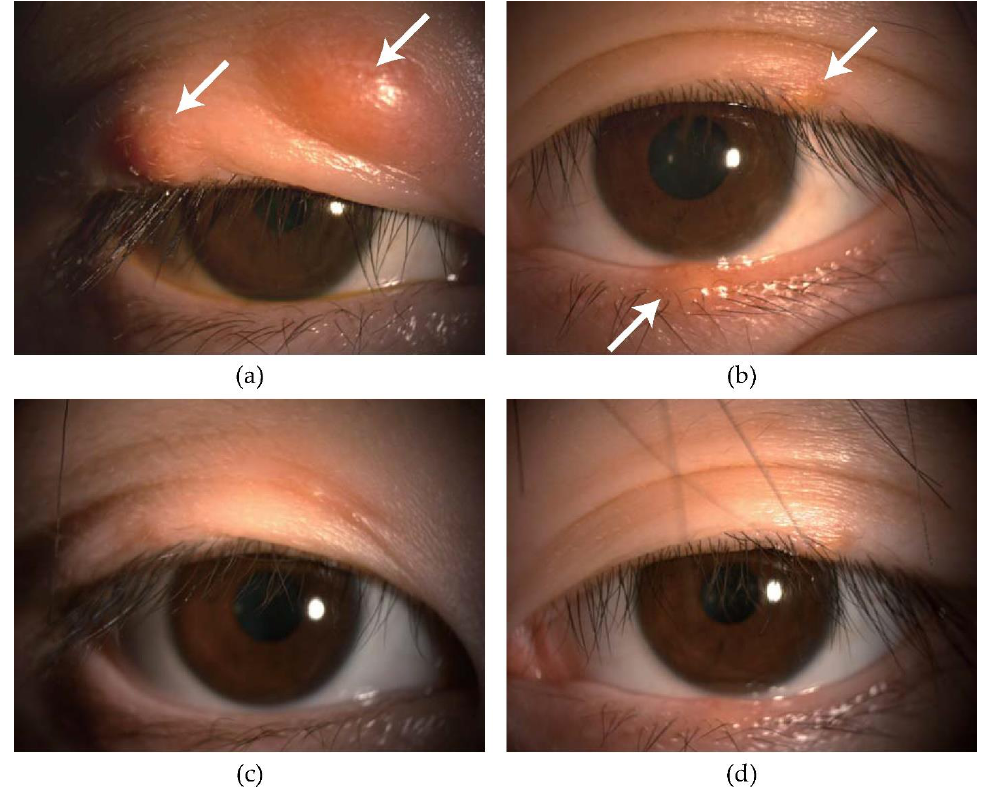
Figure 2. A 19-year-old female. Changes in chalazion in upper and lower eyelids before and after IPL. (a) Upper right eye. 18mm of chalazia (right white arrow) and 7 mm of chalazia (left white arrow) recurrenced. (b) Upper left eye. 4 mm of chalazia (upper white arrow) and 6 mm of chalazia (lower white arrow) recurrenced. (c) Two upper chalazia much improved. (d) Tow upper and lower chalazia much improved. Table 2. Characteristics of the patients with chalazion in intense pulsed light (IPL)–meibomian gland expression (MGX) (treatment group) ( n = 12) and MGX alone (control group) ( n = 12) groups before and four weeks after the final treatment session.